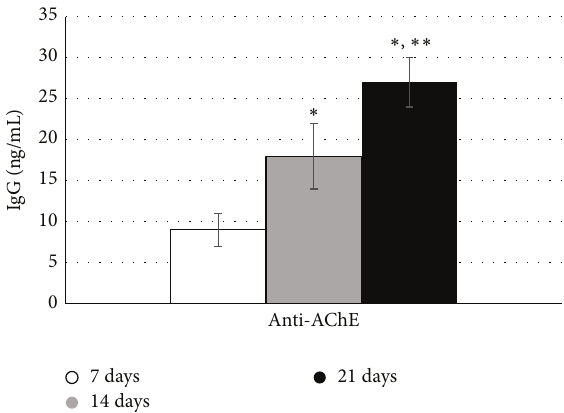
Figure 3: Serum titers of IgG against AChE, the enzyme responsible for acetylcholine hydrolysis, in hens ( 𝑛 = 7 ) administered a single dose of OPIDP-inducing phenyl saligenin phosphate (PSP, 2.5 mg/kg, im). Serum was collected at 7, 14, and 21 days. Mean levels of IgG ( ± S.E.) were significantly ( ∗ 𝑃 < 0.05 ) higher at 14 and 21 days compared to 7 days and at 21 days compared to 14 days ( ∗∗ 𝑃 < 0.05 ). Although OPIDP development is believed to be independent of AChE inhibition, some organophosphates may induce acute inhibition and phosphorylation of the